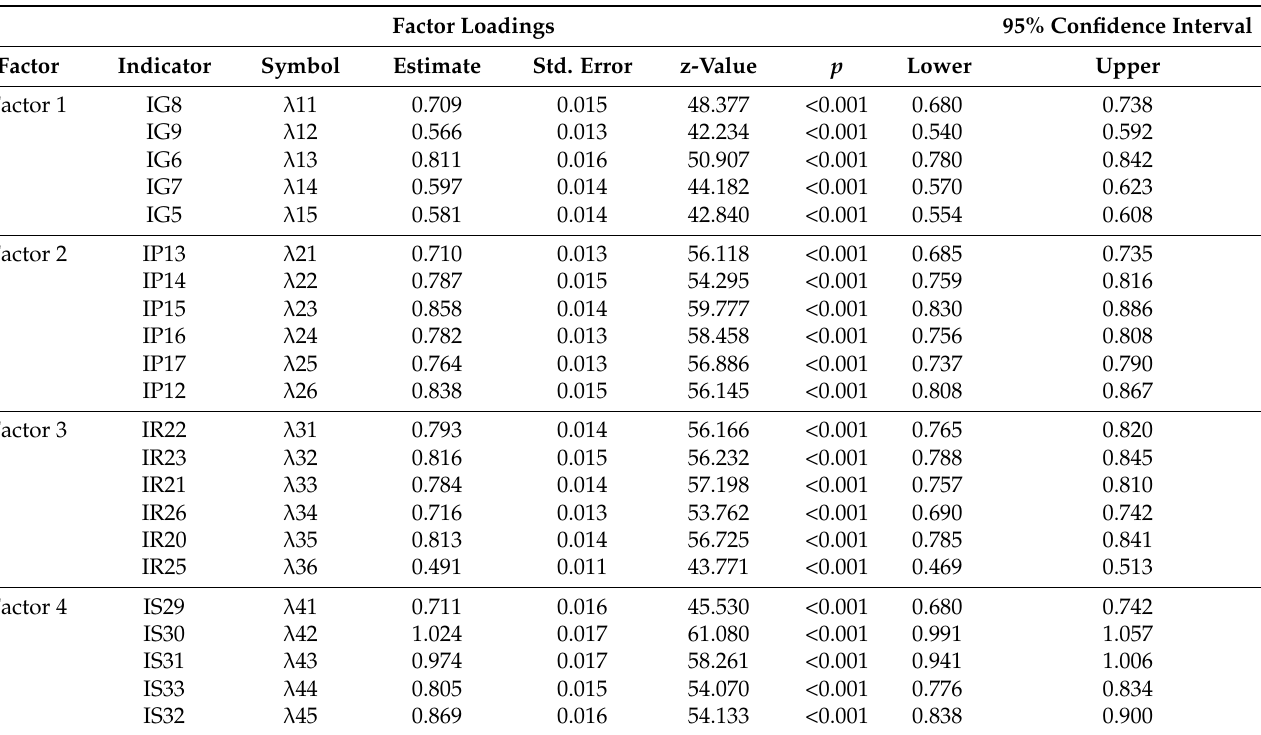
Table 3. CFA measurement model: factors, estimates of factor loadings, standards errors, lower and upper 95% CI and statistical